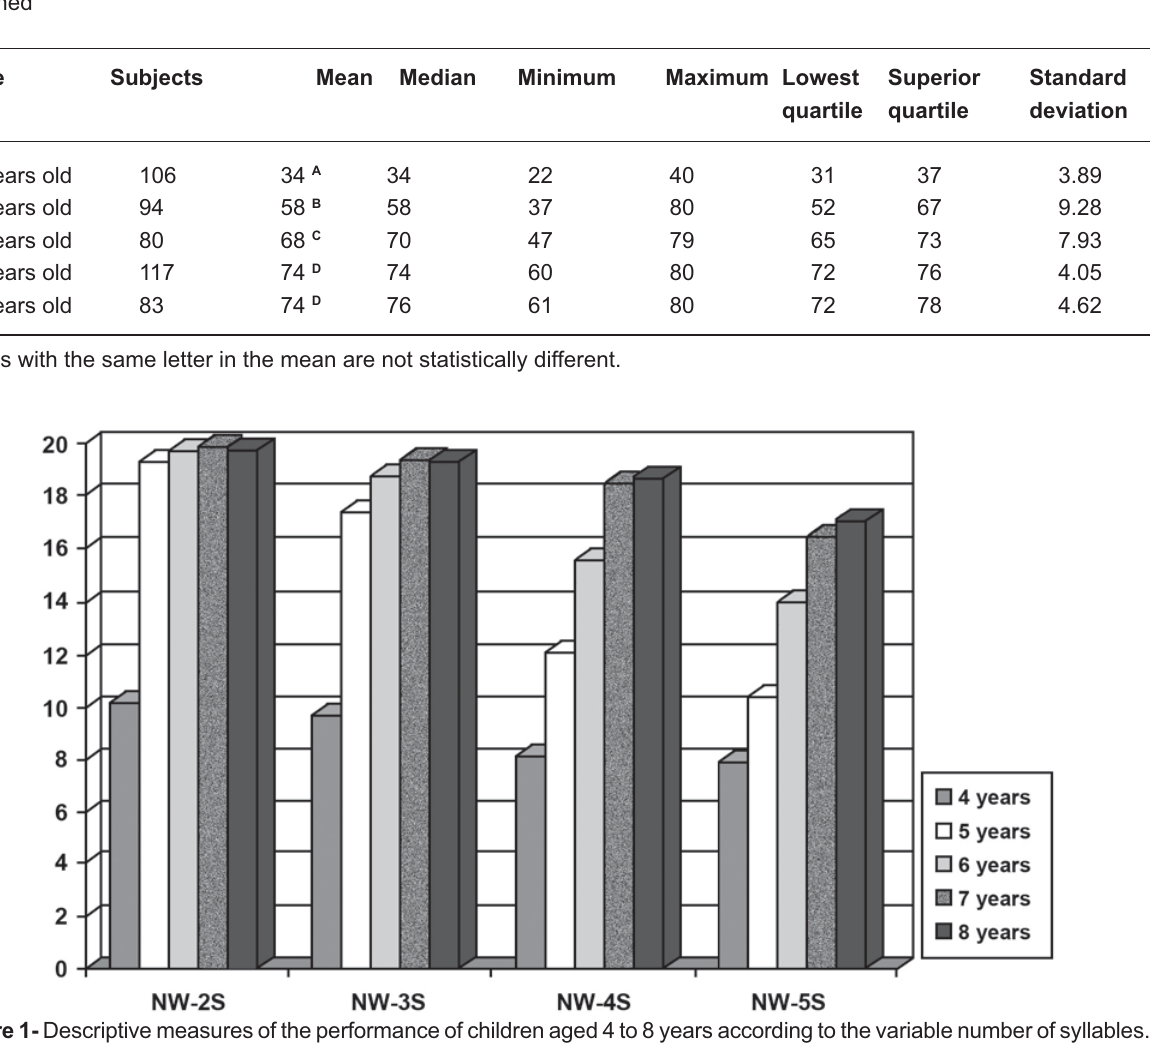
Table 1- Descriptive measures of the performance of children in the Nonword Repetition Test, considering the total scores obtained